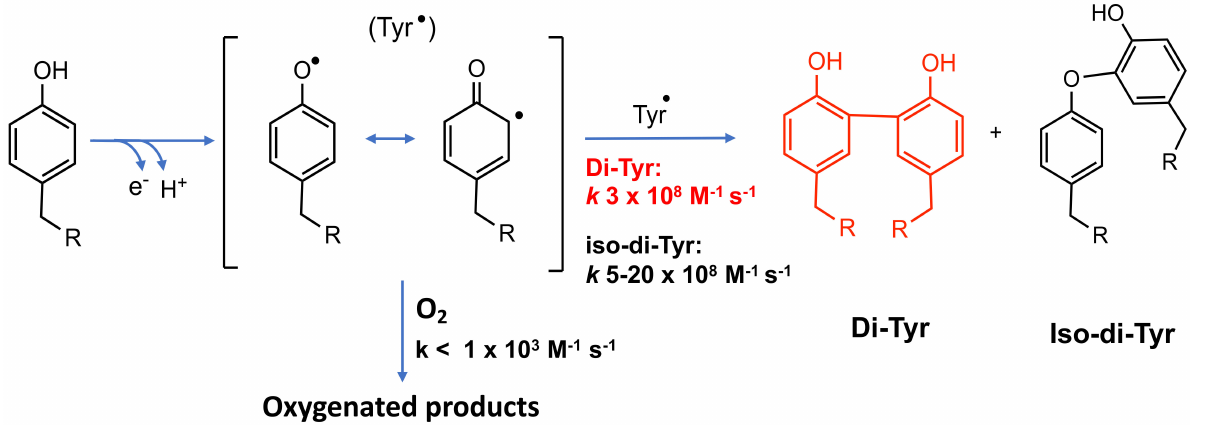
Figure 5. Formation and reactions of Tyr phenoxyl radicals (Tyr • ). Tyr • self-react to produce di-Tyr (o,o’-di-Tyr, red; iso-di-Tyr, black) or react with O 2 to generate oxygenated products. Kinetic data from